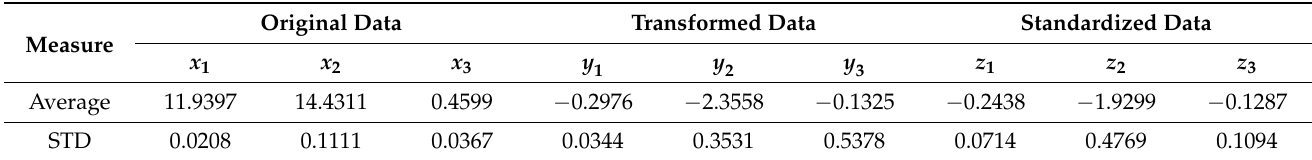
Table 10. Mean and variance of original (x), transformed (y), and standardized (z)